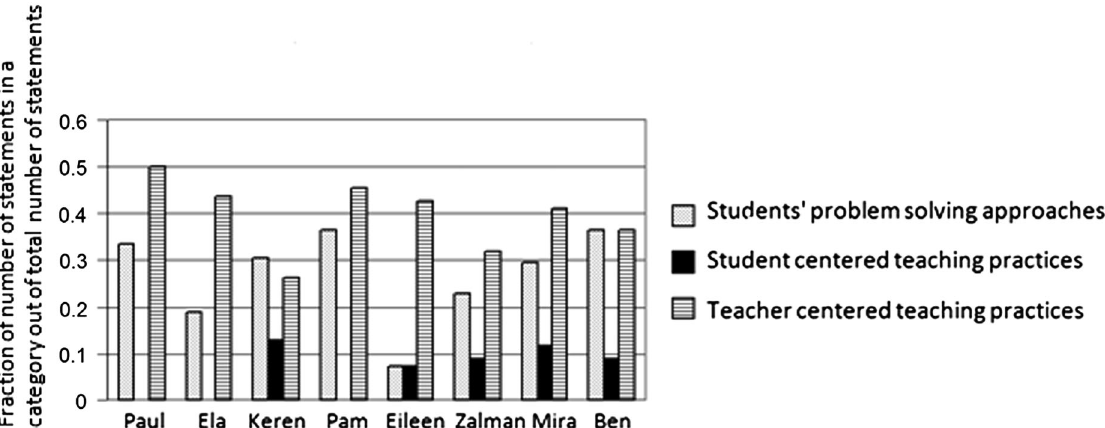
FIG. 6. A distribution of workshop participants’ answers to the prequestionnaire.